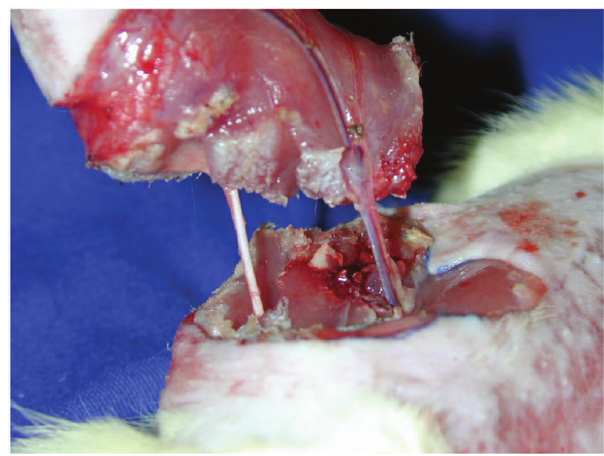
Figure 1 - Amputated limb with preservation of vessels and nerves.